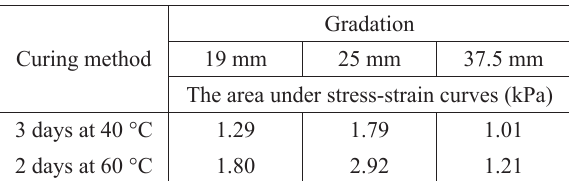
Table 5. The area under stress-strain curves in optimum samples in different curing methods (kPa)